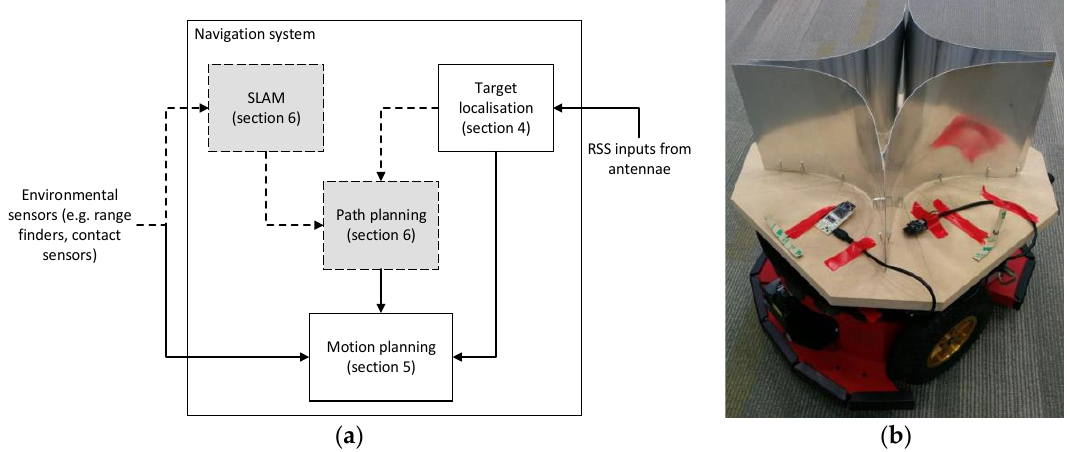
Figure 2. ( a ) System block diagram of the autonomous robot and ( b ) Prototype implementation on a Pioneer 3-DX research robot (© 2017 IEEE from [10]).